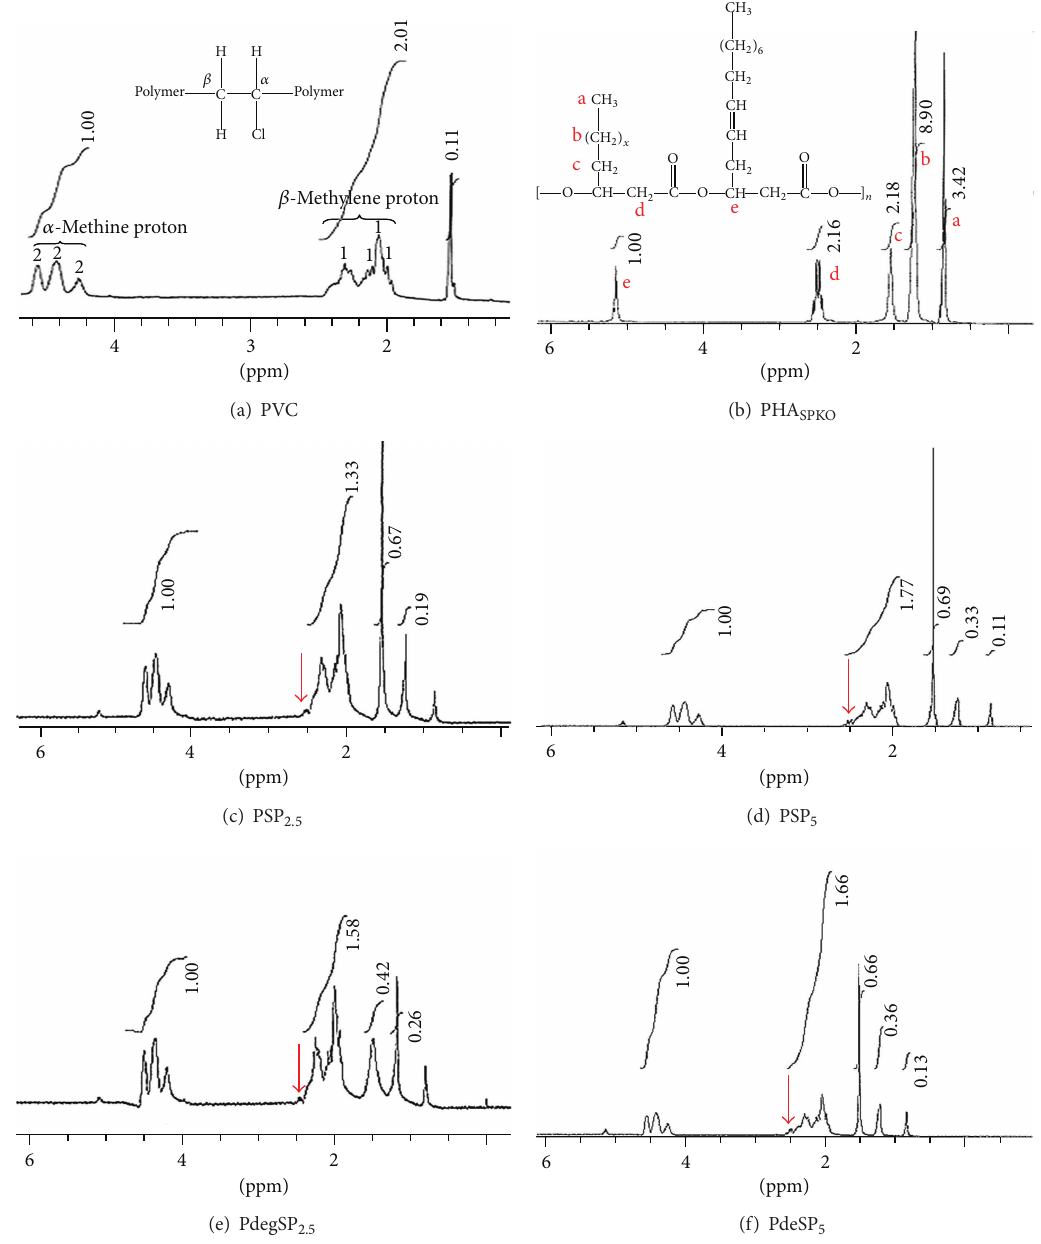
Figure 3: 1 H-NMR spectra of (a) PVC, (b) PHA SPKO , (c) PSP 2.5 , (d) PSP 5 , (e) PdegSP 2.5 , and (f) PdeSP 5 binary blends.